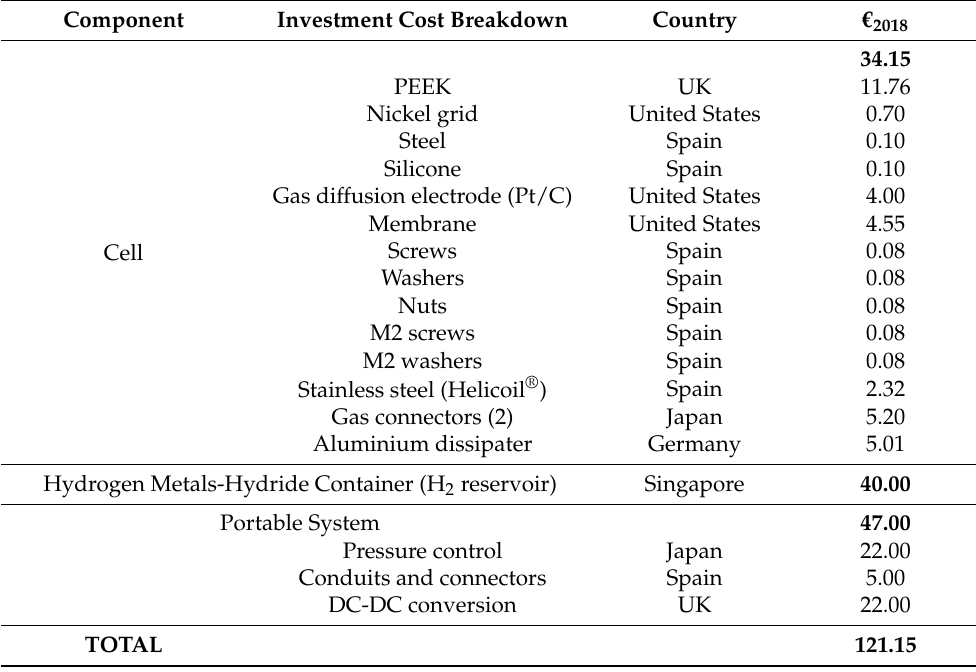
Table 3. Investment cost disaggregation and supplier